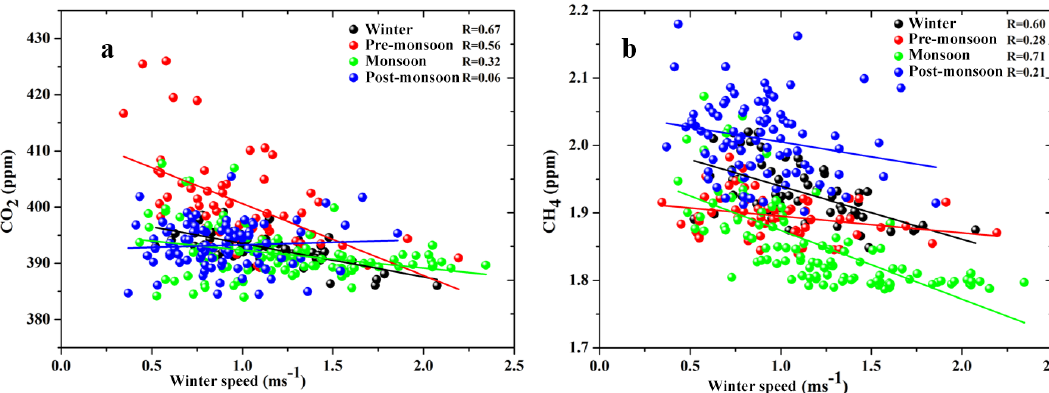
Figure 6. (a–b) Daily mean scatter plot of wind speed and GHGs (CO 2 and CH 4 ) . Table 3. Seasonal amplitudes of CO 2 and CH 4 over the study region arriving from different directions. Wind direction Winter Pre-monsoon Monsoon Post-monsoon CO 2 CH 4